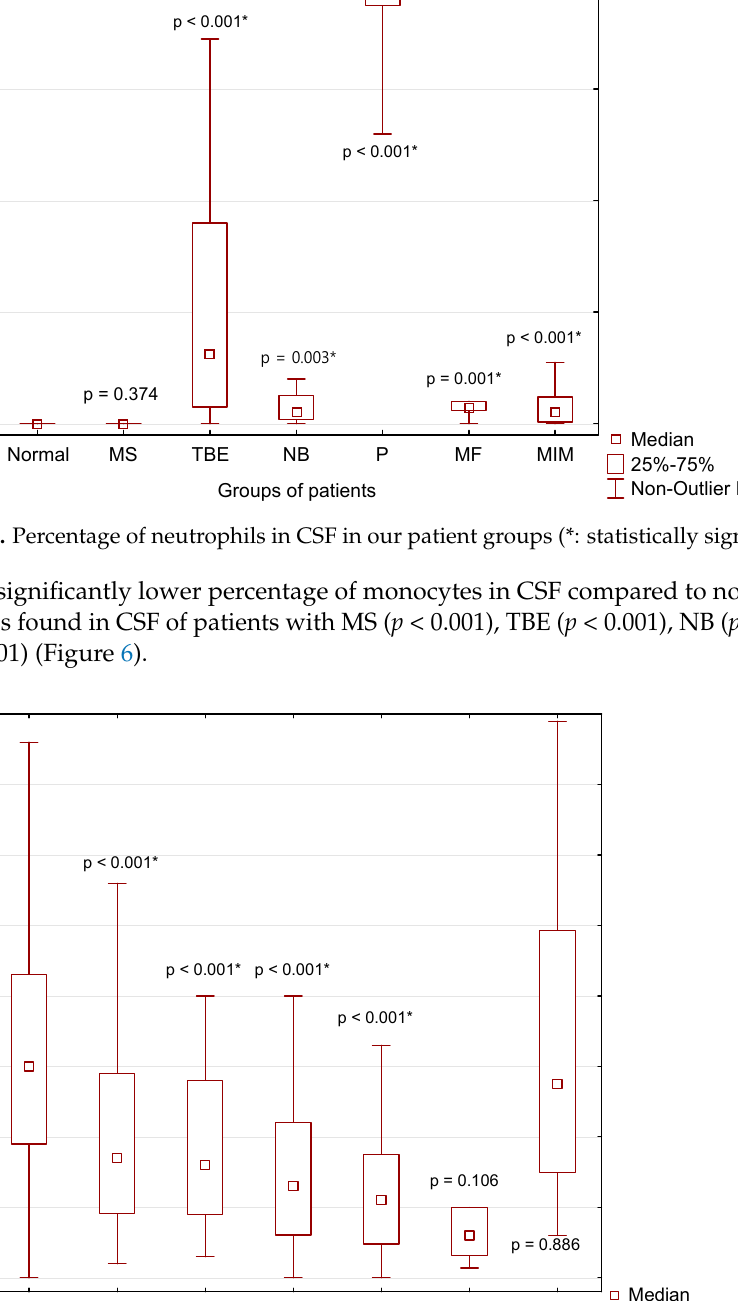
Figure 6. Percentage of monocytes in CSF in our patient groups (*: statistically significant) .